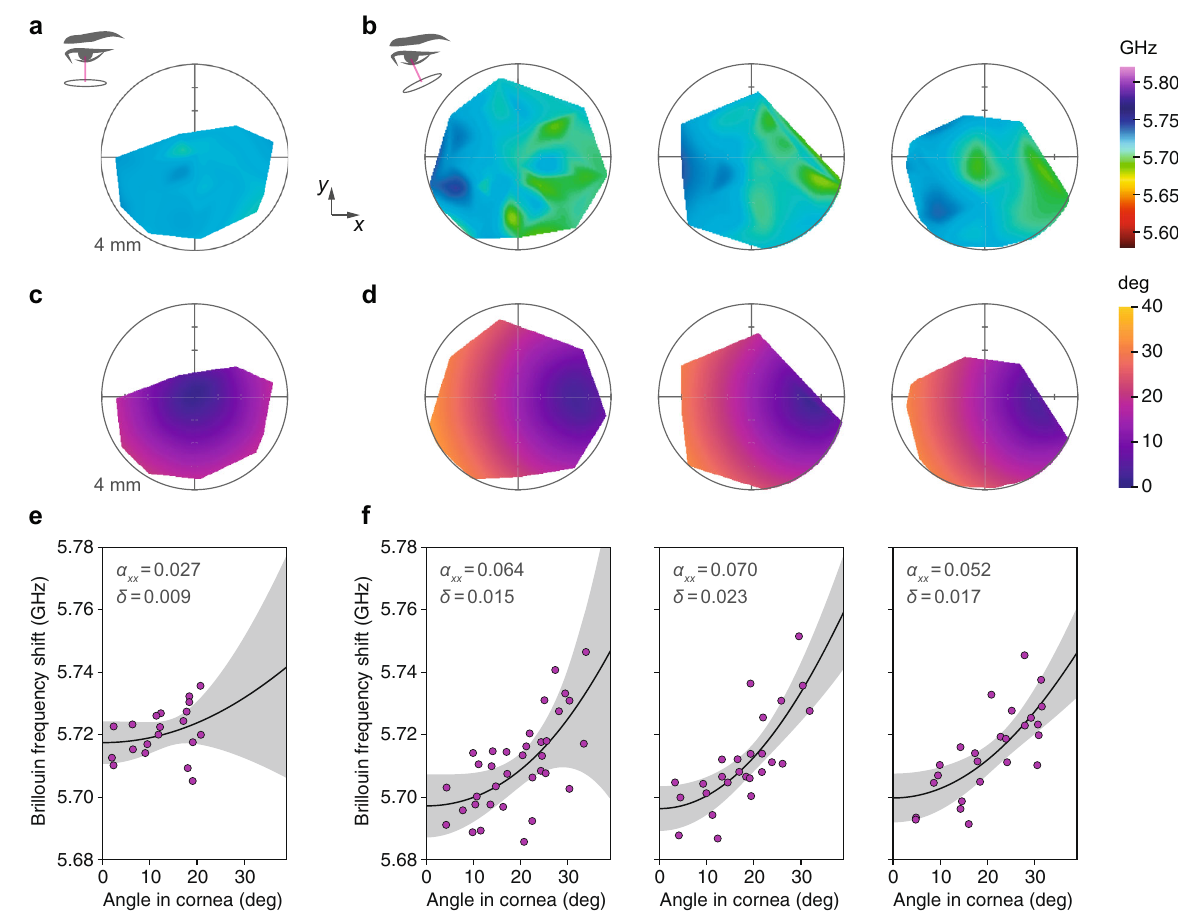
Fig. 5 Anisotropy in vivo in Brillouin maps of the human cornea ( n = 4, 3:1 M:F, 31.5 ± 2.4 Y/O). a Brillouin frequency shift map of a normal subject with laser incidence angle close to 0° at the corneal apex (see diagram at left). b Brillouin maps of three normal subjects for a steeper set of laser incidence angles (see diagram). c and d Maps showing computed laser incidence angle corresponding to the Brillouin maps above. The laser-cornea incidence angle varies slightly as the laser is translated in x (left-right) and y (up-down) to create the Brillouin map due to corneal curvature. e and f Plot of Brillouin values for each map versus computed incidence angle. The increasing Brillouin shift with angle is consistent with expected corneal anisotropy. Individual map data points (shown in magenta) were fi t to the weak transverse isotropy model (Eq. (3)). Best- fi t curves are plotted (solid line) with 95% con fi dence bands (gray). Fitted values of α xx and δ are